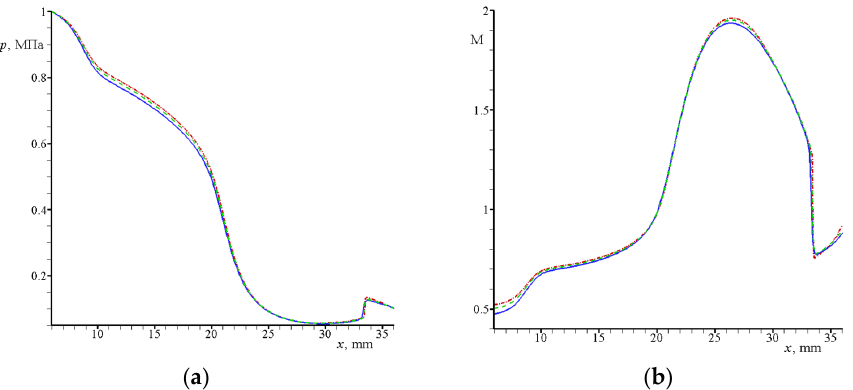
Figure 6. Distribution of pressure ( a ) and Mach number ( b ) on the axis y = 0 in the steady gas flow calculated with different numbers of cells: the solid, dashed, and dash-and-dot lines correspond to N c = 51,783, N (cid:48) c = 207,132, and N (cid:48)(cid:48) c = 828,528,